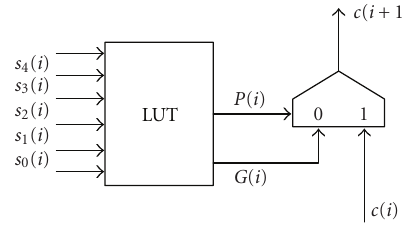
Figure 13: FPGA carry-chain circuit for Ad- I.